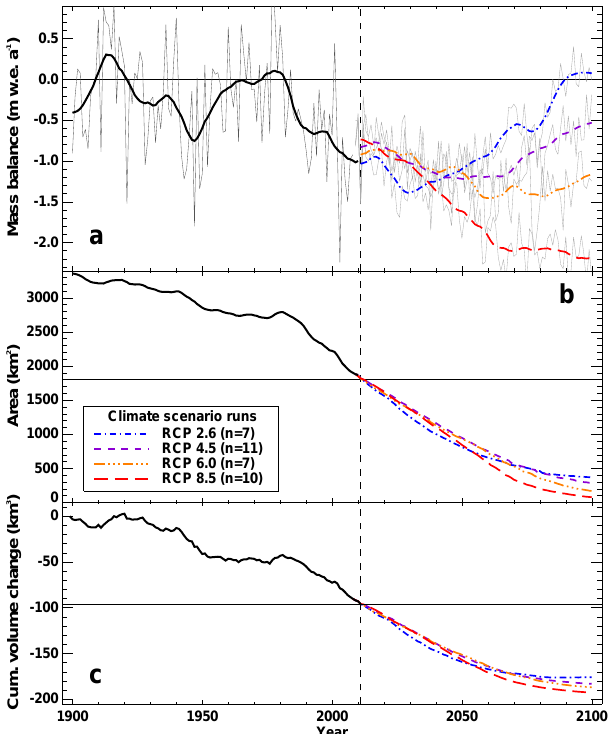
Fig. 5. Mass balance, area and ice volume change series extrap- olated to all glaciers in the European Alps for 1900–2100. The dashed line indicates the onset of future modelling results (2011). (a) Area-weighted average of mean specific annual mass balance (see Eq. 3). For 2011–2100 the ensemble mean mass balance of n GCMs according to the four RCPs is shown. Annual series (grey) are 11-yr low-pass filtered (bold). (b) Total glacierized area in the European Alps. (c) Cumulative ice volume changes assuming an ice density of 900kgm − 3 .